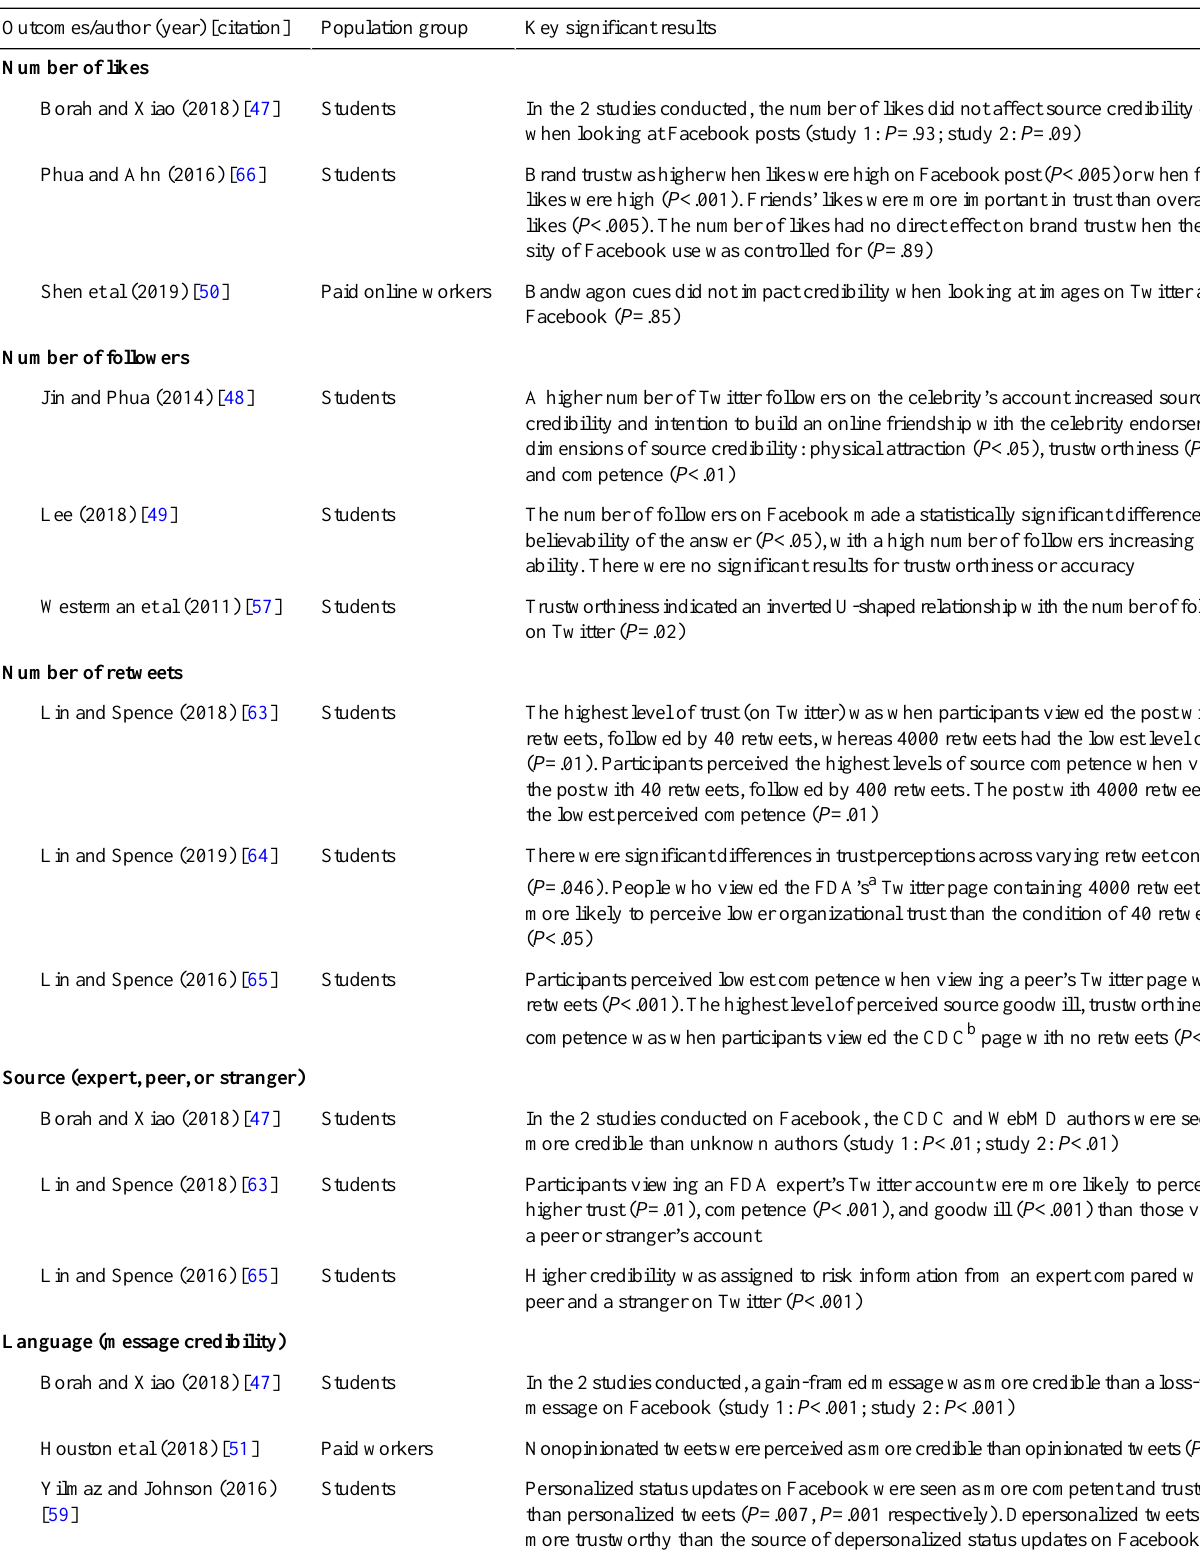
Table 1. Main findings of included papers and their effect on credibility or trust, separated by manipulated variable: number of likes, number of followers, number of retweets, source, and